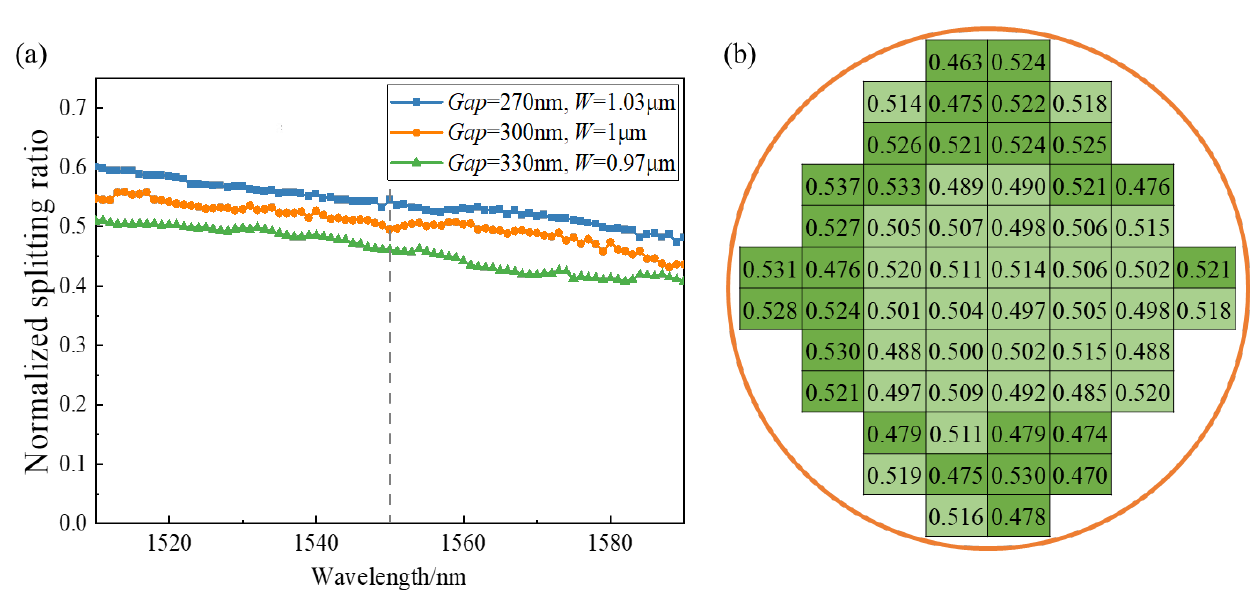
Figure 7. ( a ) Wavelength dependence of transmission of bent DC (cross port) with different sizes; ( b ) wafer-level measurements of splitting ratio at cross port of bent DC.